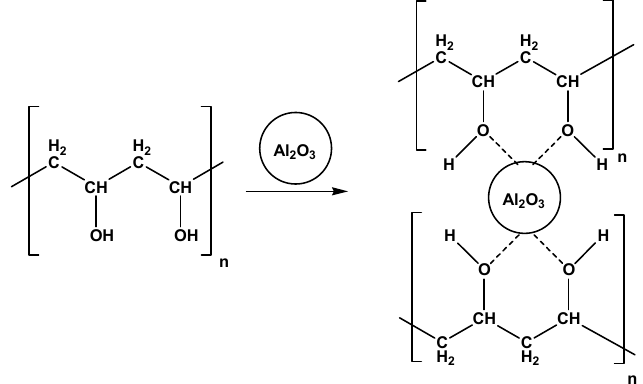
Figure 1. Structure of a PVA-Al 2 O 3 nanocomposite.